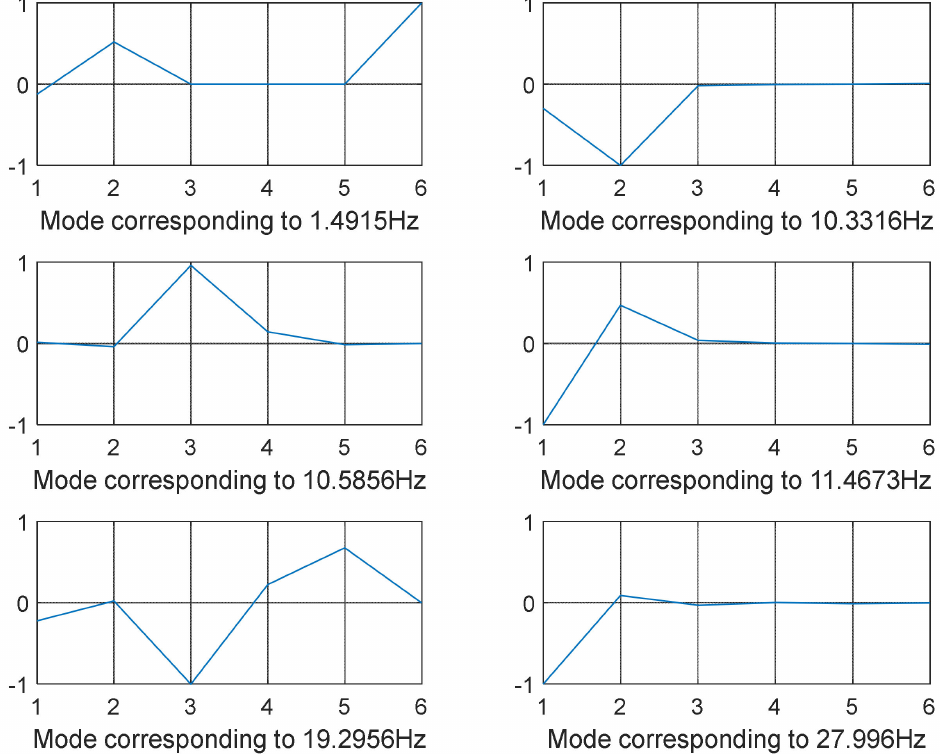
Figure 3. GWO-optimized mode shapes 1–6 (12-DOF model—shaking loads